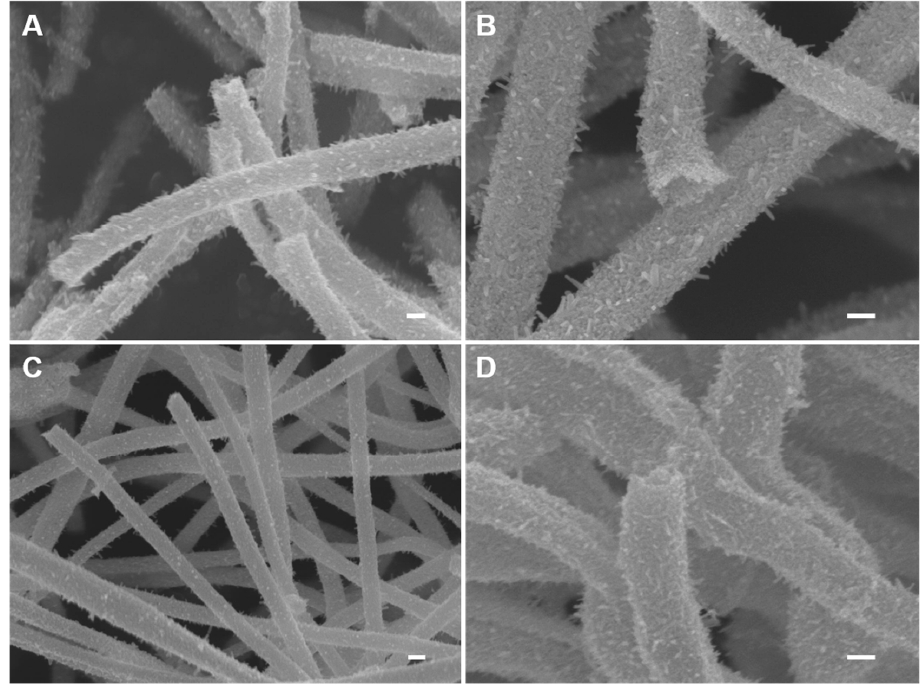
Figure 1. SEM images of ( A , B ) IrO 2 nanotubes and ( C , D ) Ir metal nanotubes. (scale bar = 100